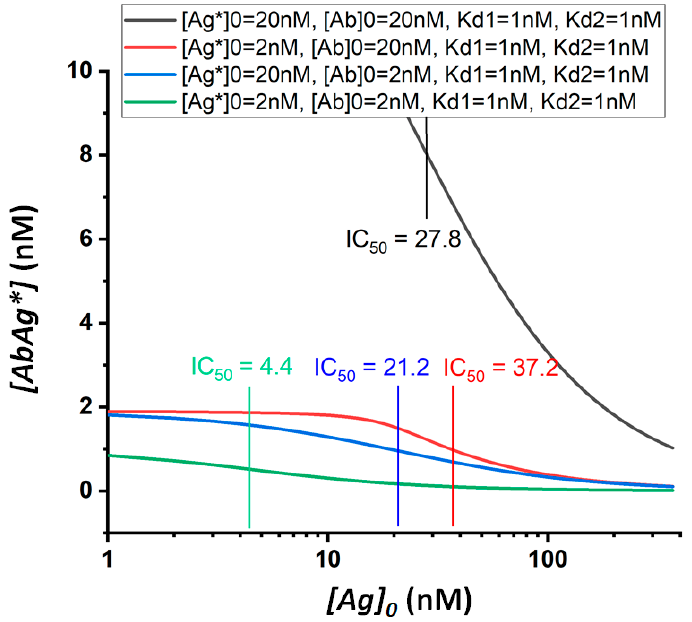
Figure 2. Theoretical calibration dependences of equilibrium competitive immunoassay at different values of the initial concentrations of the labeled antigen and antibodies.